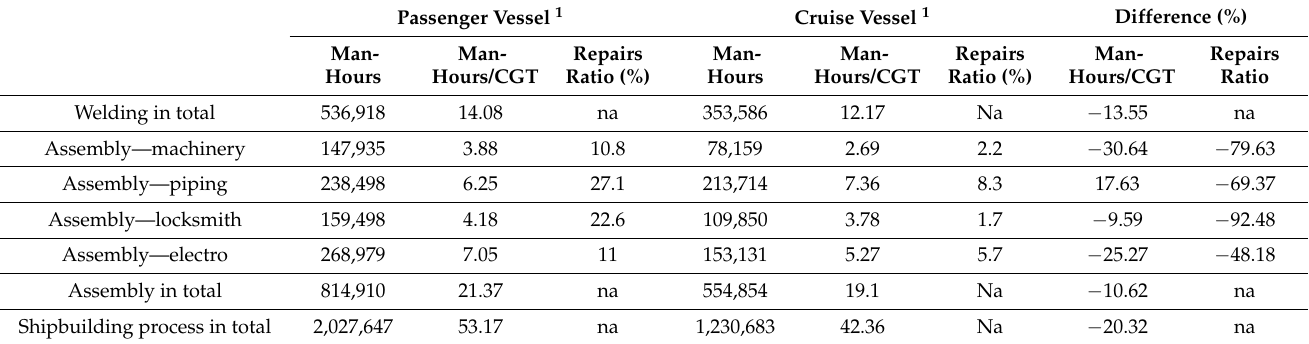
Table 3. Working hours—welding (total) and outfitting.